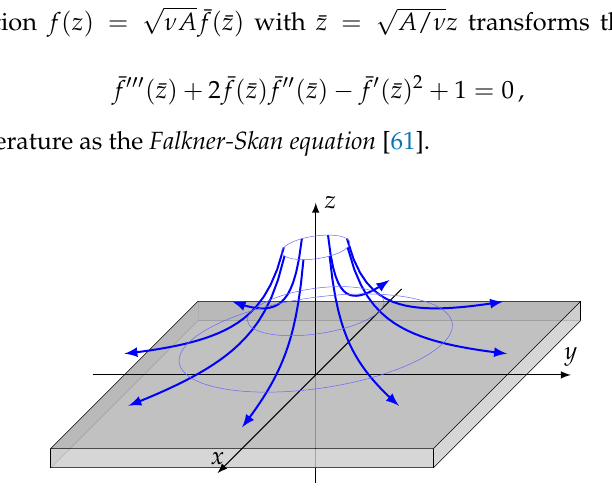
Figure 1. Schematic of an axisymmetric stagnation flow in the vicinity of a solid